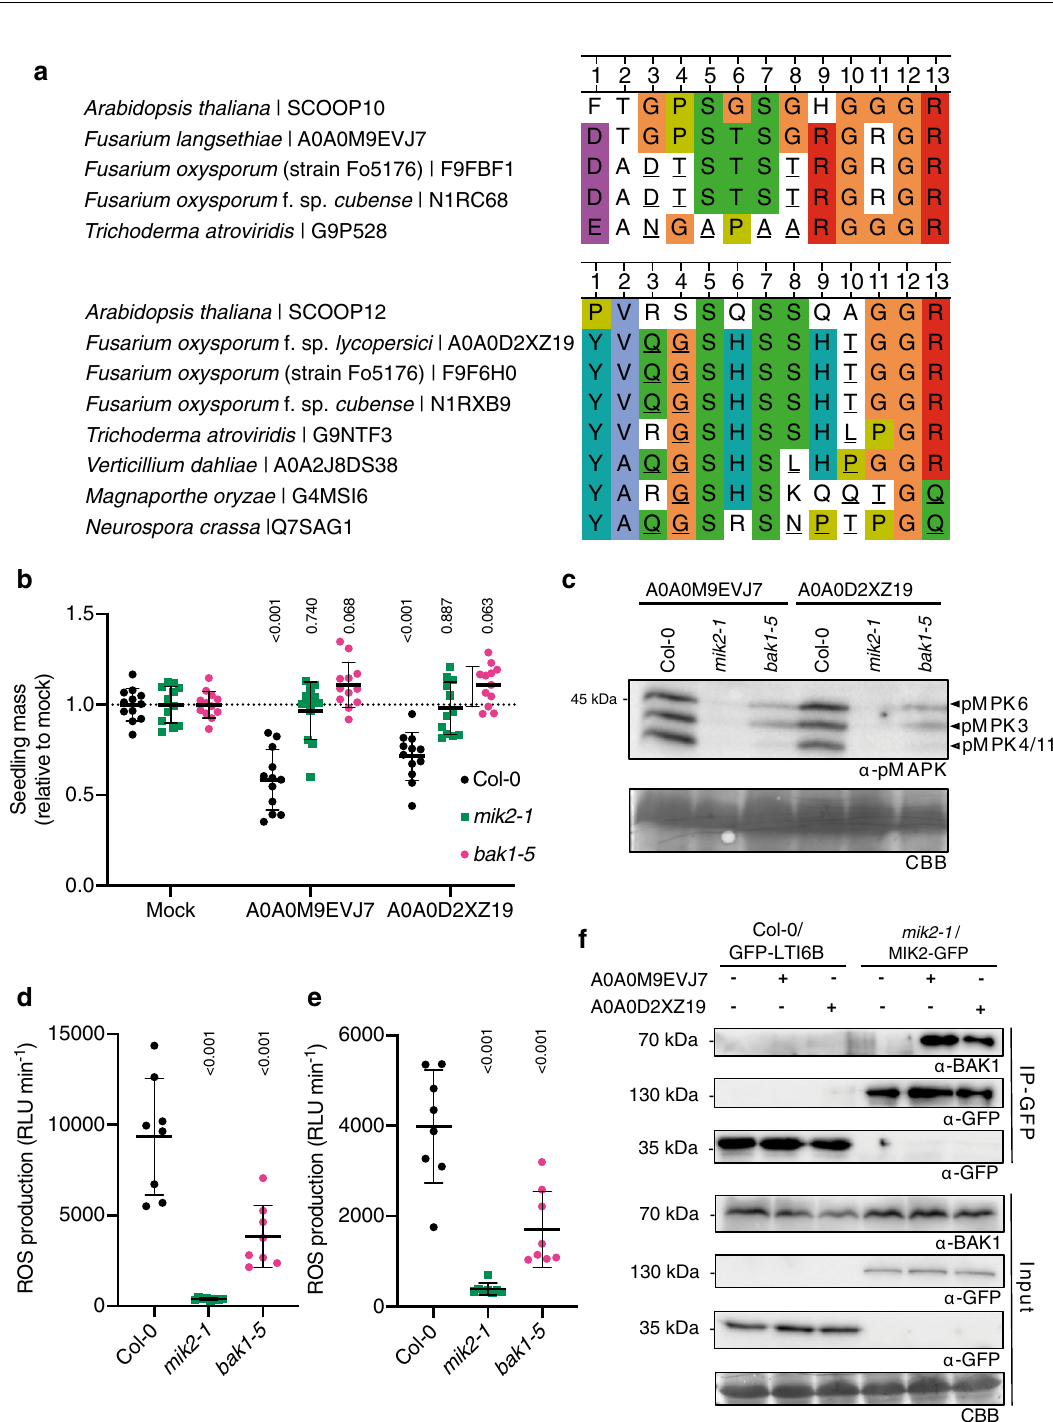
Fig. 4 Fusarium-derived peptides are induced MIK2-dependent responses. a Alignments of the SCOOP-like motifs from A0A0M9EVJ7 and A0A0D2XZ191 in closely related fungal species with the most closely related Arabidopsis SCOOP based on amino acid identity. Residues that are not found in any Arabidopsis SCOOP are underlined b Relative fresh weight of 14-day-old seedlings grown in the presence of 1 μ M A0A0M9EVJ7 or A0A0D2XZ19 for 10 days relative to mock ( n = 12 seedlings). A line represents mean; error bars represent S.D. P -values are derived from a Dunnett ’ s multiple comparison test comparing the treatment to mock for each genotype following a two-way ANOVA. c Western blot using α -p42/p44-ERK recognizing phosphorylated MPK6, MPK3, and MPK4/11 in seedlings treated with 1 μ M A0A0M9EVJ7, A0A0D2XZ19 or mock for 15 min. Membranes were stained with CBB, as a loading control. d , e Integrated ROS production in leaf disks collected from 4-week-old A. thaliana plants induced by d 1 μ M A0A0M9EVJ7 or e 1 μ M A0A0D2XZ19 application over 40 min ( n = 8 leaf disks). Line represents mean; error bars represent S.D. P -values are derived from a Dunnett ’ s multiple comparison test comparing the treatment to mock for each genotype following a one-way ANOVA. f Co-immunoprecipitation of BAK1 with MIK2 – GFP from mik2-1 /MIK2-GFP and GFP-LTI6B from Col-0/GFP-LTI6B seedlings treated with 1 μ M A0A0M9EVJ7, 1 μ M A0A0D2XZ19, or water for 10 min. Western blots were probed with antibodies α -GFP and α -BAK1. All experiments were performed and analyzed three times with similar results. CBB Coomassie brilliant blue, ROS reactive oxygen